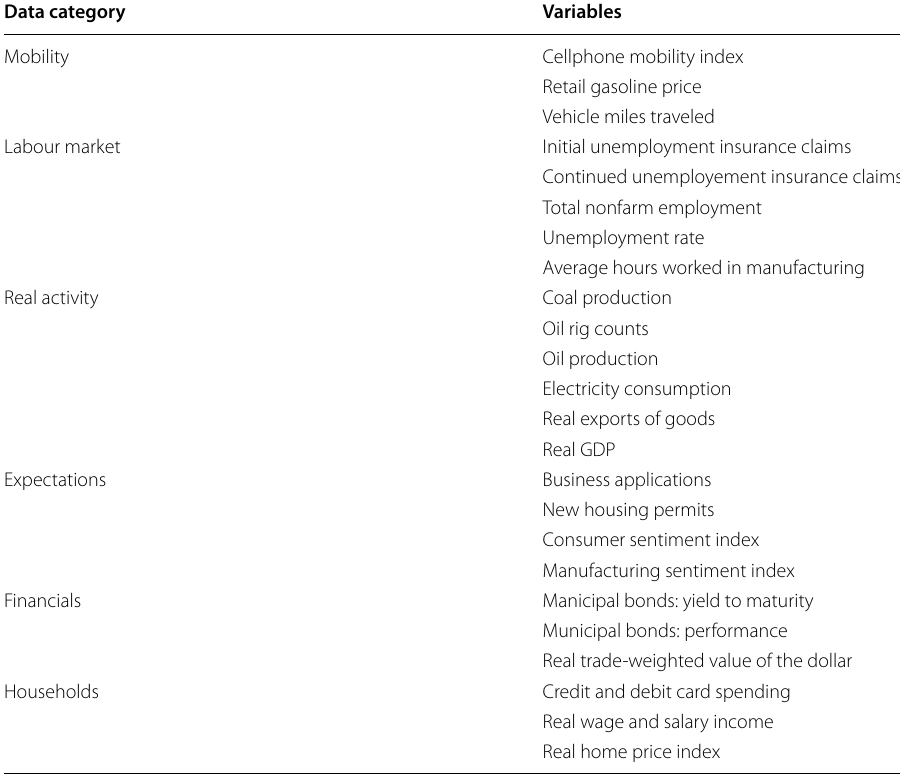
Table 8 Dataset for state-level economic conditions